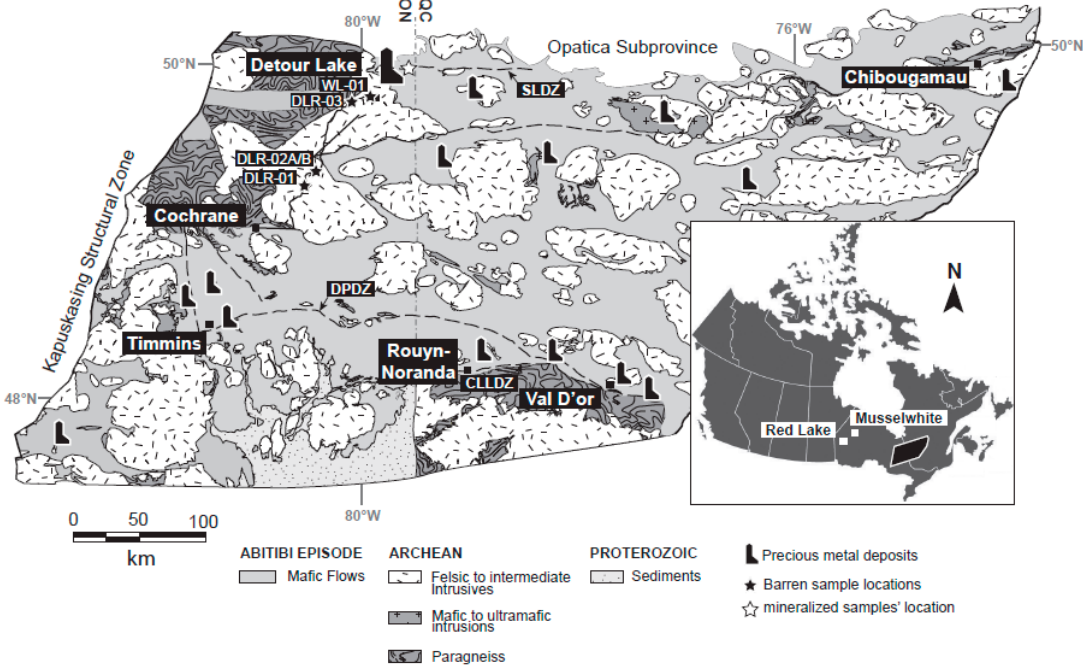
Figure 1. Geological map of the Abitibi Subprovince of eastern Canada showing the location of the Detour Lake mine along an east-west trending high-strain deformation zone (SLDZ) north of the well-known Abitibi greenstone belt [15]. Barren sample locations are shown with black stars. Location of Red Lake and Musselwhite mining districts are also shown on inset map of Canada.